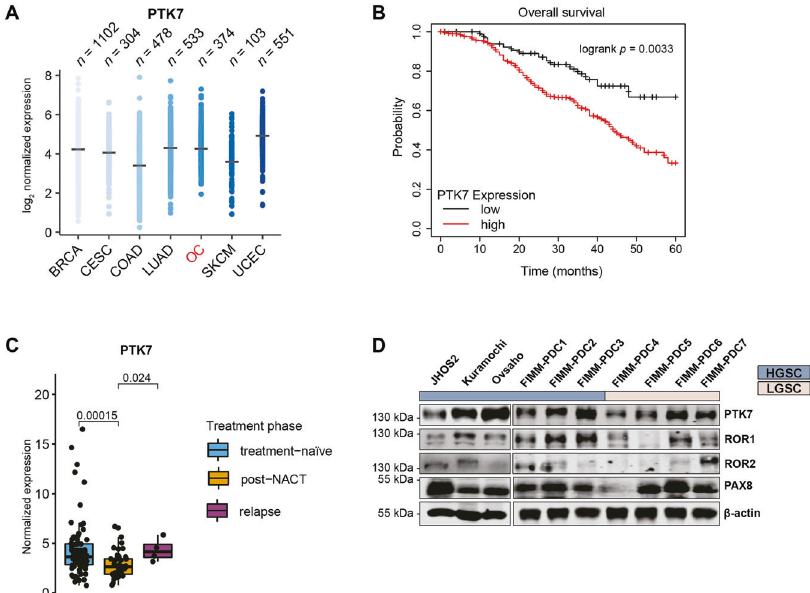
Fig. 1 The expression and clinical signi fi cance of PTK7 in OC. A Expression pro fi le of PTK7 in the seven most common cancers in women from The Cancer Genome Atlas (TCGA): BRCA (breast invasive carcinoma), COAD (colon adenocarcinoma), LUAD (lung adenocarcinoma), OC (ovarian serous cystadenocarcinoma), SKCM (skin cutaneous melanoma), and UCEC (uterine corpus endometrial carcinoma). B Kaplan-Meier analysis [53] of GSE9891 dataset shows that PTK7 expression in OC tumors is signi fi cantly correlated with poor overall survival. C Expression levels of PTK7 in treatment-naïve ( n = 75), post-NACT ( n = 46), and relapsed ( n = 4) HGSC patient samples in the DECIDER cohort; p -values were calculated using the Wilcoxon rank sum test. D Immunoblot analysis of ROR1, ROR2, and PTK7 expression in HGSC and LGSC cell lines and PDCs. β -actin was used as loading control. A representative of 3 independent immunoblots is